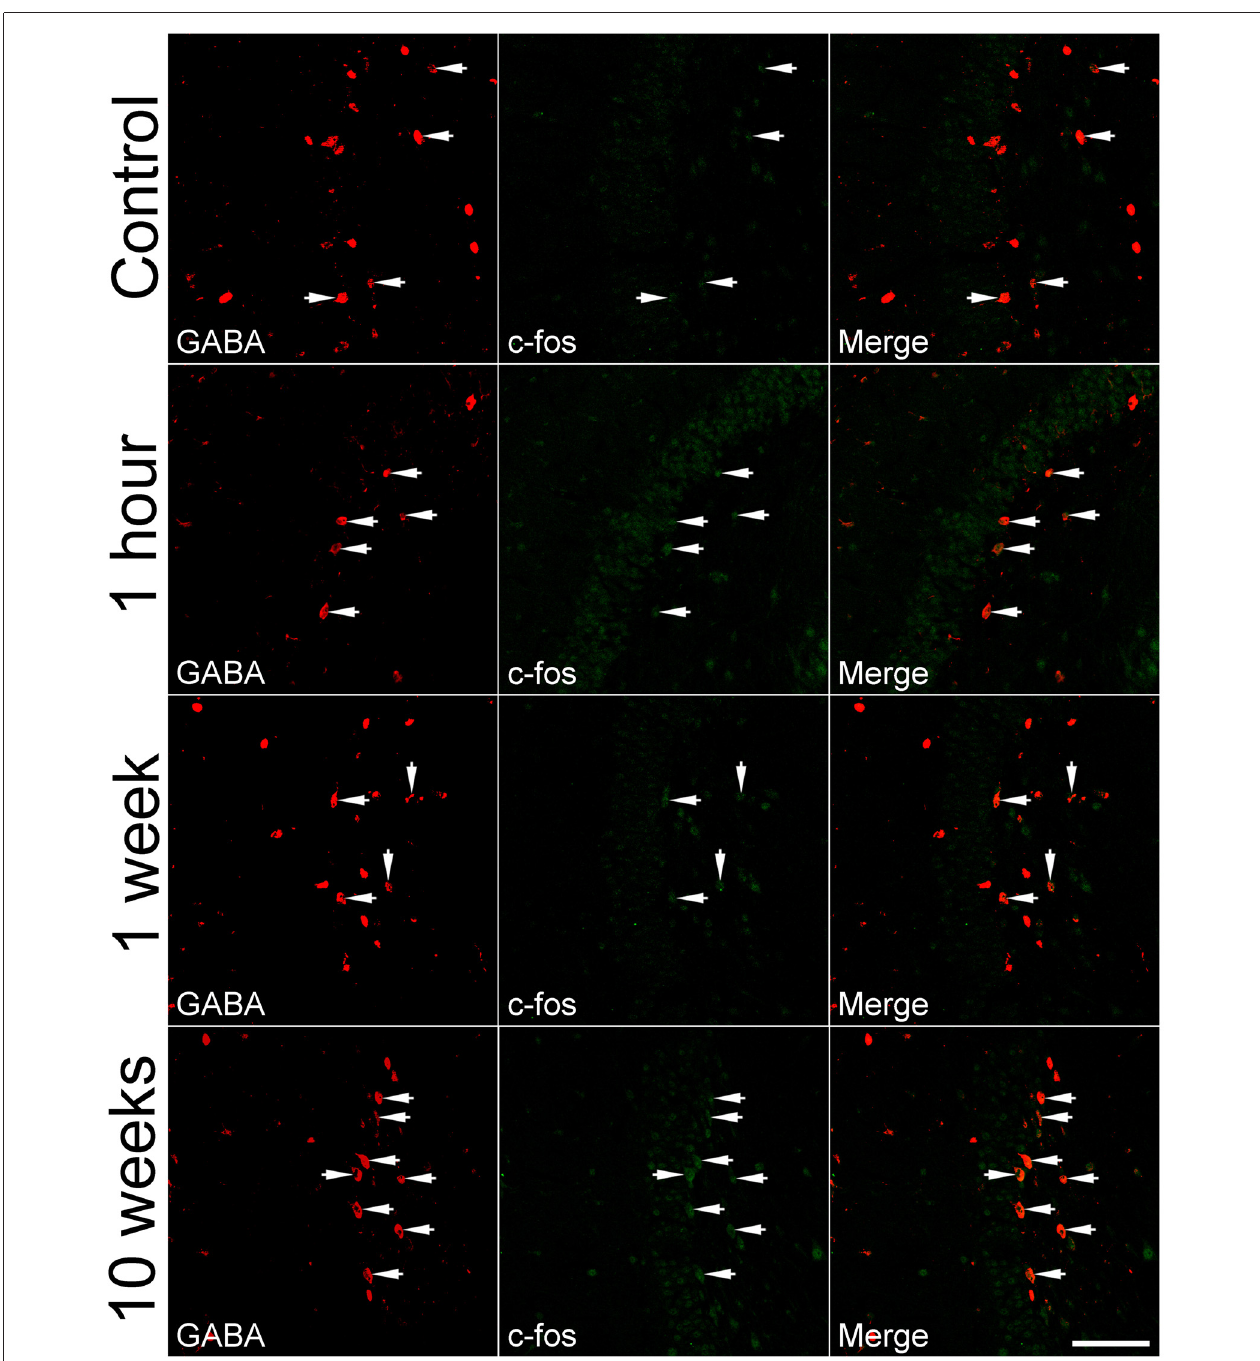
FIGURE 2 | Representative images show c-fos expression in GABA-immunoreactive cells in the dentate gyrus at 1 h, 1 week, and more than 10 weeks after SE . SE was induced by an intraperitoneal injection of pilocarpine. The controls (Control) received equivalent volume of normal saline instead of pilocarpine. Left column: GABA immunoreactivity; Middle column: c-fos immunoreactivity; Right column: overlay of GABA and c-fos immunoreactivities. Arrows indicate GABA-positive cells with c-fos expression. Scale bar = 100 µ m (applicable to all panels).